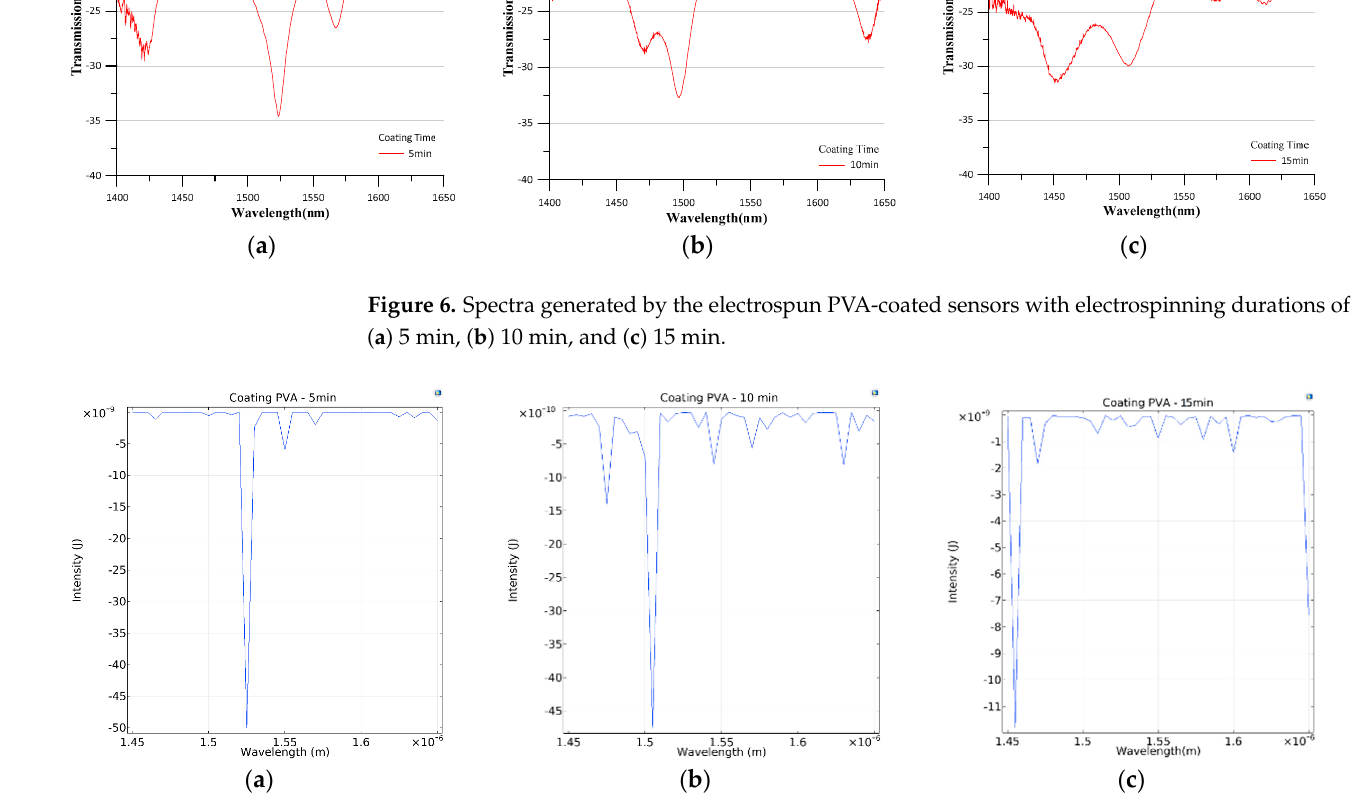
( c ) Figure 8. Energy fields simulated in COMSOL for sensors with electrospinning durations of ( a ) 5 min, ( b ) 10 min, and ( c ) 15 mined in the main text as Figure 1 etc. 4.3. Temperature Experiments on the Electrospun PVA-Coated Sensor of the U-Shaped Optical Fiber The U-shaped optical fiber sensors were tested for temperature stability in three cy- cles, with their spectral losses analyzed using an OSA. The results in Figure 9 show that